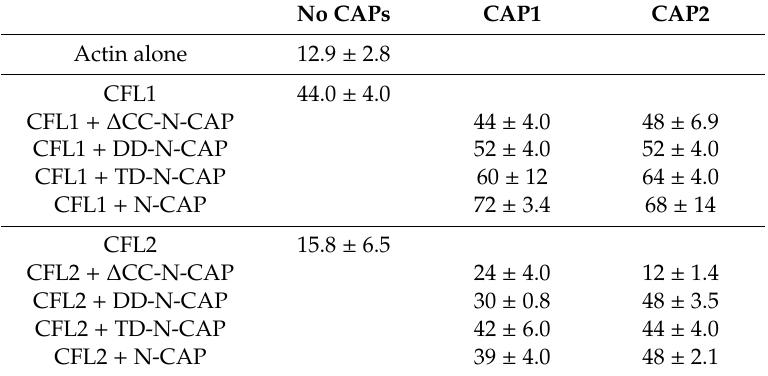
Table 3. E ff ects of N-CAP constructs on cofilin-mediated F-actin depolymerization rates. Initial rates of F-actin depolymerization were measured from the slopes of the pyrene–actin depolymerization